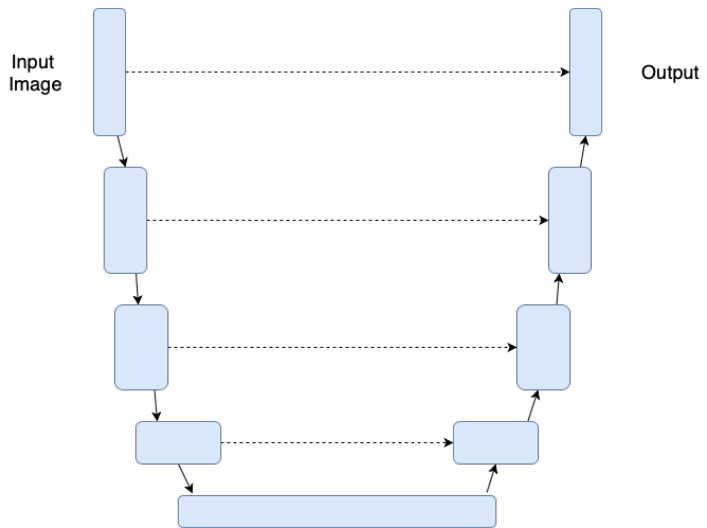
Figure 5. General schema of Unet architecture: input and output have the same